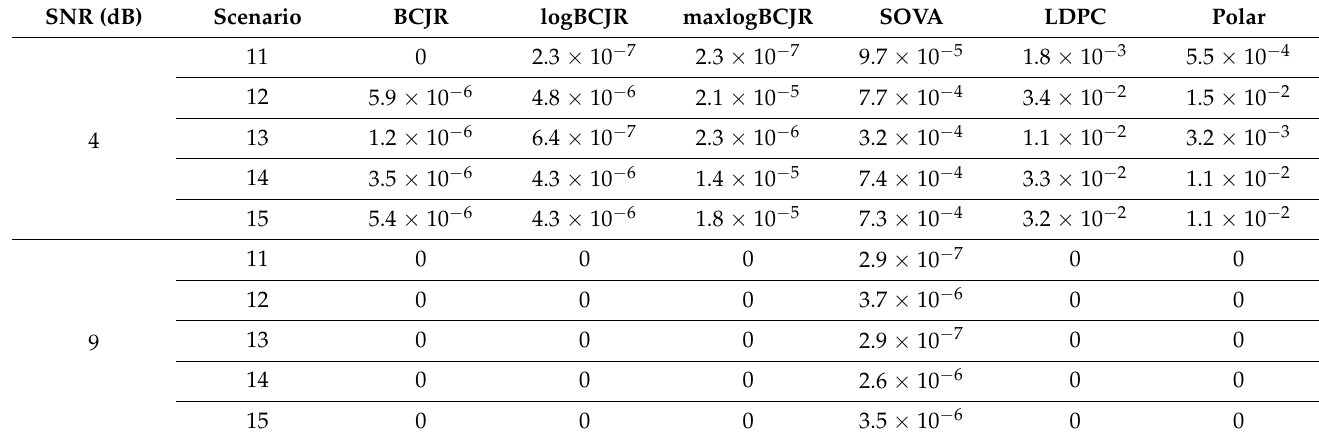
Table 12. BER values for 4 and 9 dB SNR, 512-bit